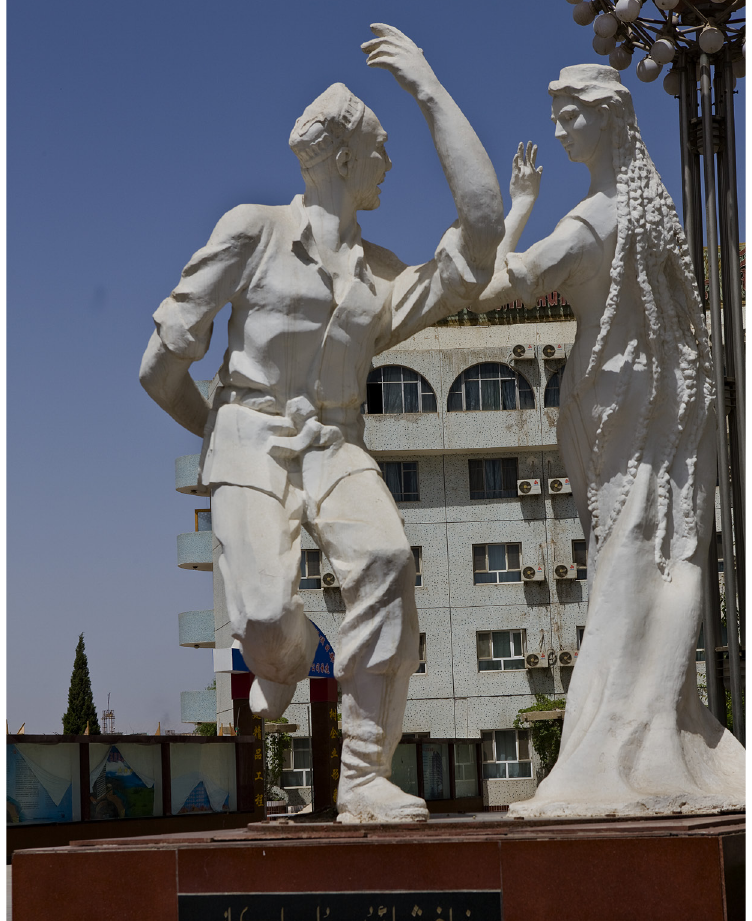
Figure 2: Statue at a government-run hotel in Kashgar that informs visitors that Xinjiang is “a land of singing and dancing.” Photo: John